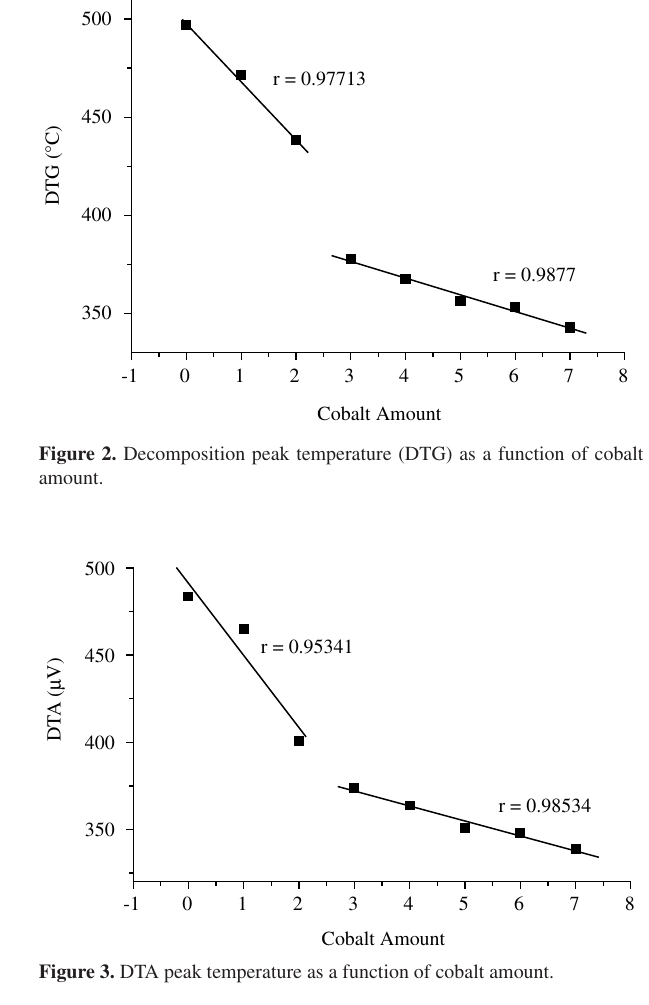
Figure 3. DTA peak temperature as a function of cobalt amount.